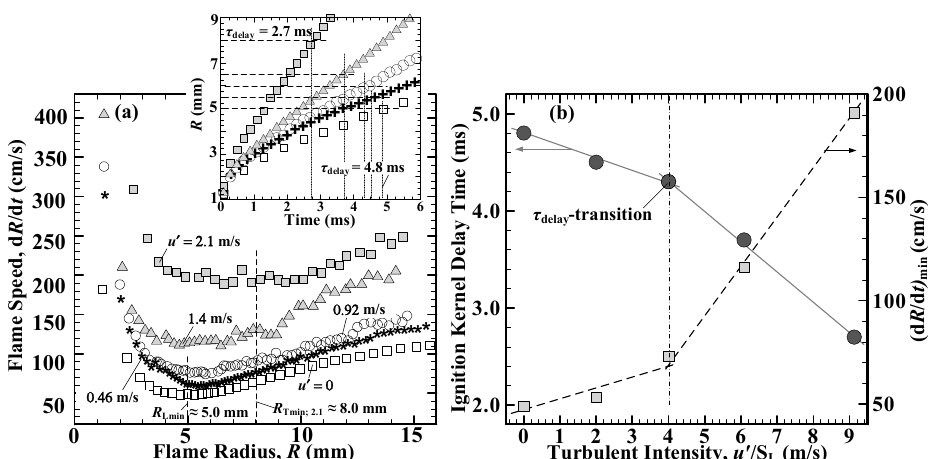
Figure 4. ( a ) Flame speed of the early flame kernel development plotted against flame kernel radius at different E ig using the same experimental settings in quiescence, obtained from the raw flame kernel radii versus time (the inset figure). ( b ) The ignition kernel delay time ( τ delay ) measured at R Lmin ≈ 5.0 mm, with the minimum flame speed (d R /d t ) min plotted against the normalized E ig /MIE L .